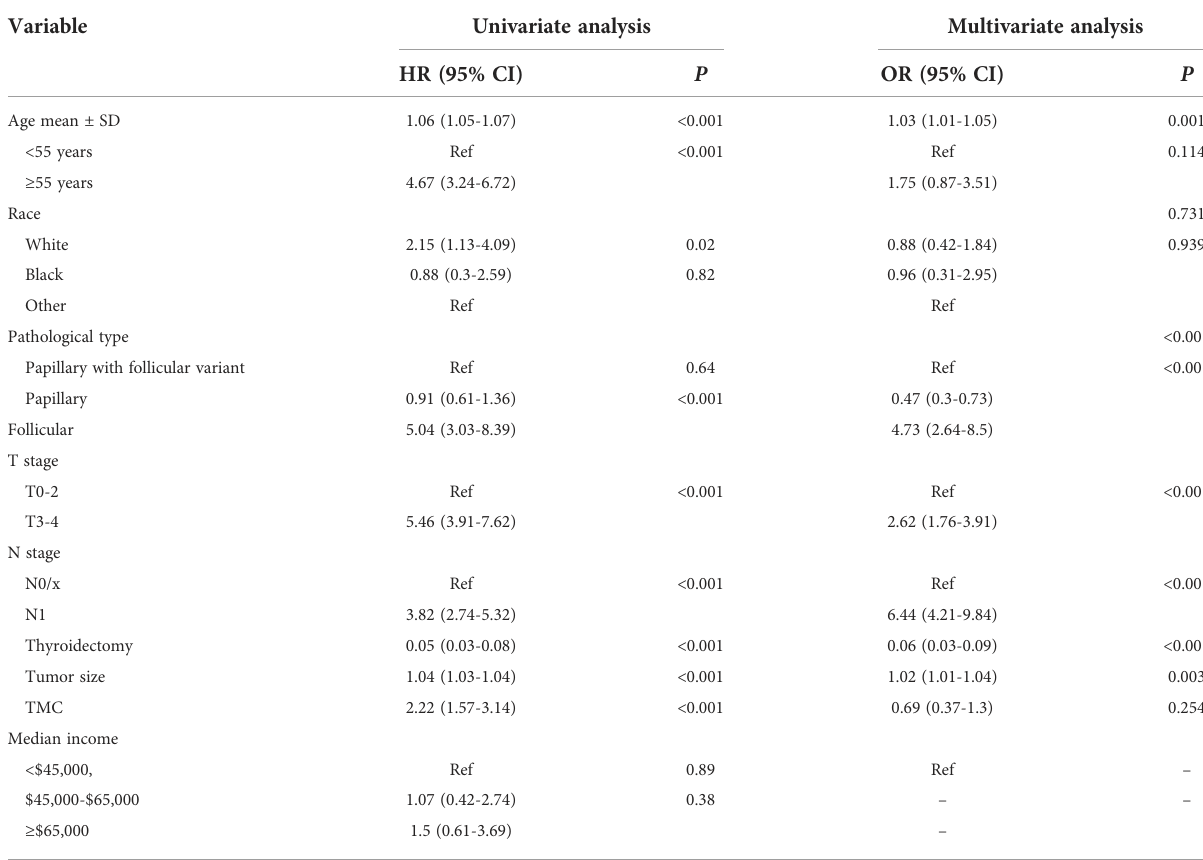
TABLE 2 Univariate and multivariate logistics regression analyses of the risk factors of DM in the training cohorts. Variable Univariate analysis Multivariate